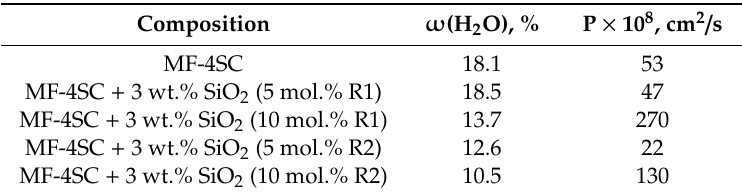
Table 3. The water uptake of membranes and the di ff usion permeability of 0.1 M HCl solution into water through membranes in the H + -form (samples obtained by casting)